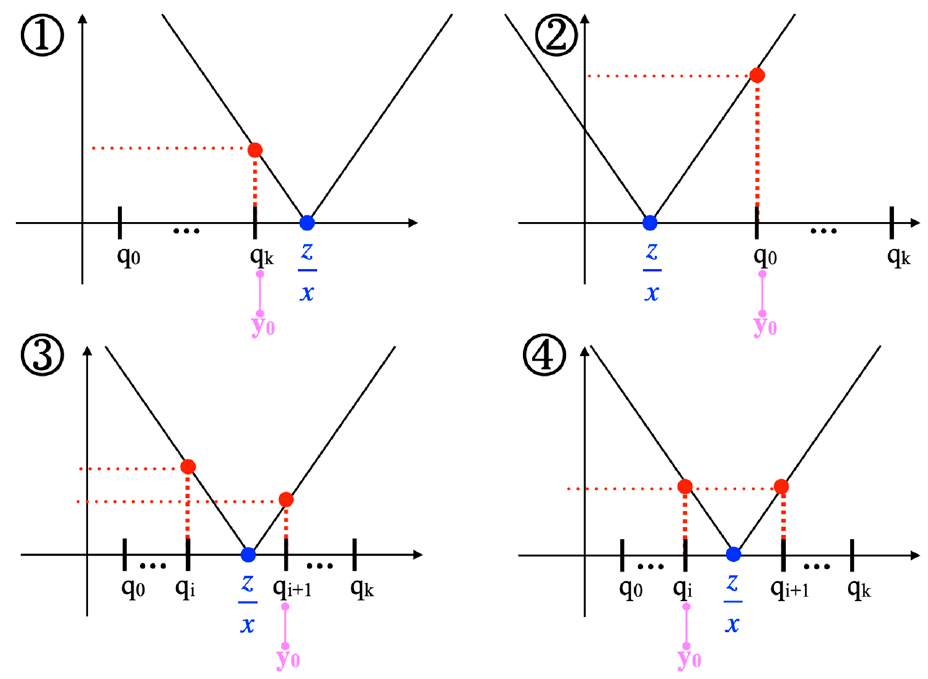
Figure 12. The potential positions of z / x with respect to the denominators q 0 , . . . , q k .